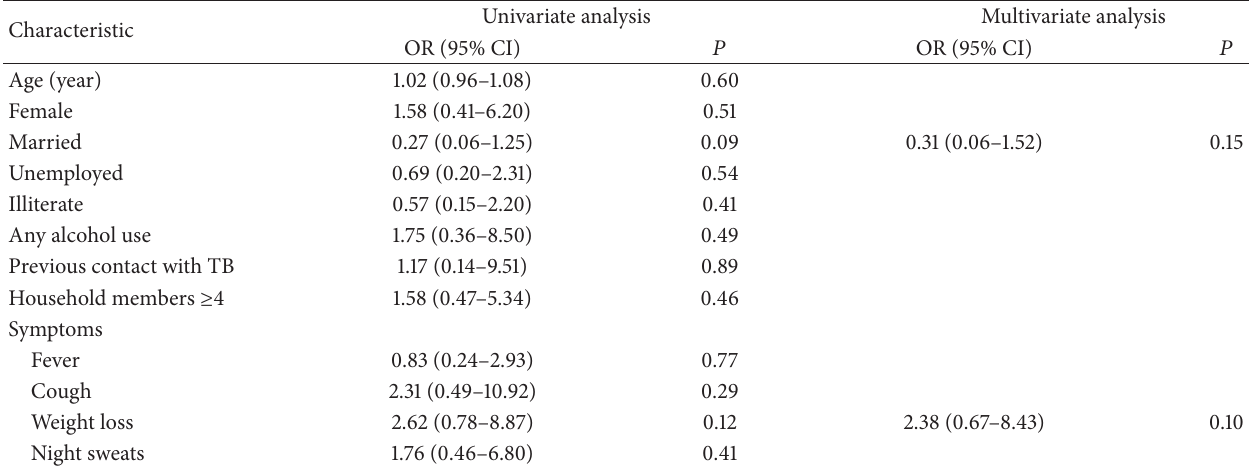
Table 3: Risk factors for TB in HIV positive individuals in Gondar, North West Ethiopia,